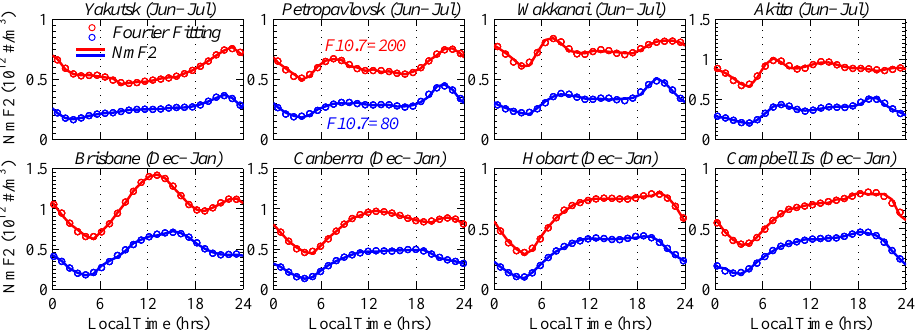
Figure 3. Local time variations of mid-latitude Nm F2 at the two solar activity levels in local summer; the solid lines are the results derived from the Nm F2– F 10 . 7 quadratic fittings, and the circles are the Fourier fittings of the solid line data.